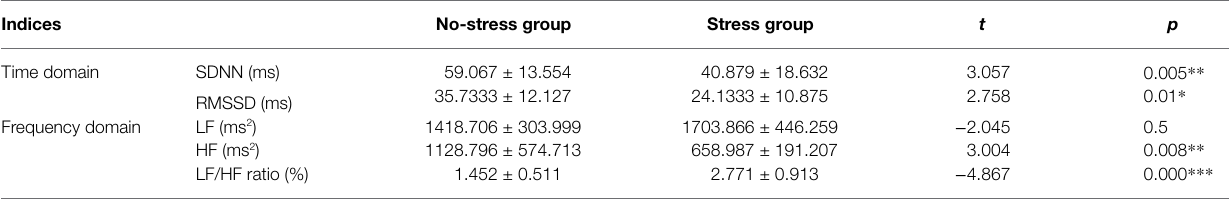
TABLE 5 | Mean and standard error for baseline heart rate variability (HRV) measures during the money game.